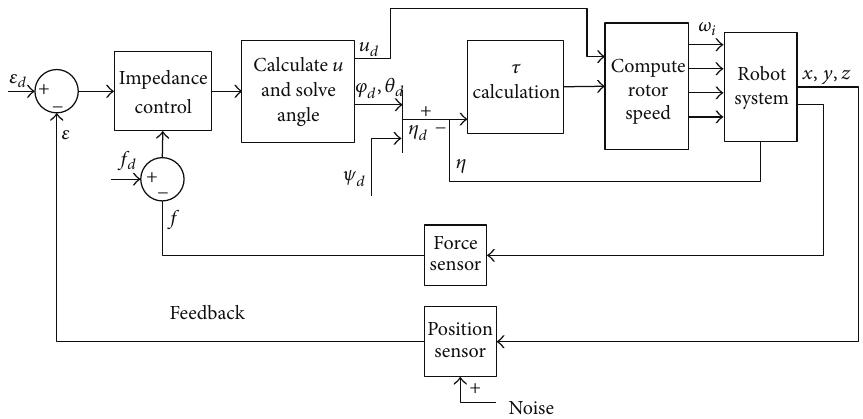
Figure 5: System schematic for impedance control